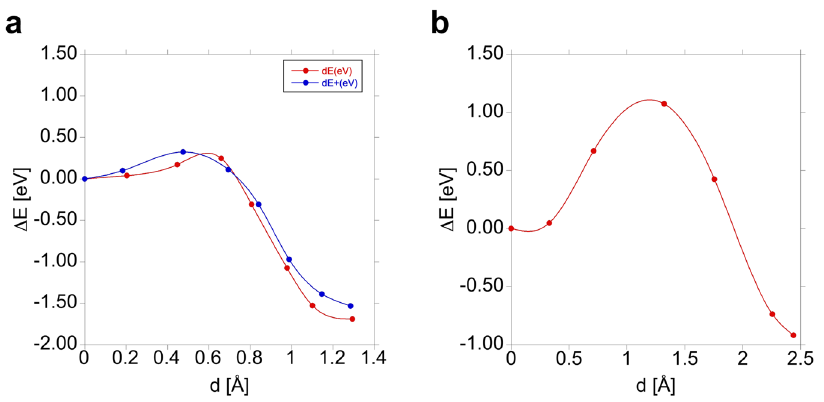
Fig. 4 | The change of the total energy with respect to the initial state, as a function of the distance travelled by the C-interstitial when a (C – Si) Si split- interstitial approaches a C Si substitutional. The curves are cubic spline fi ts, to